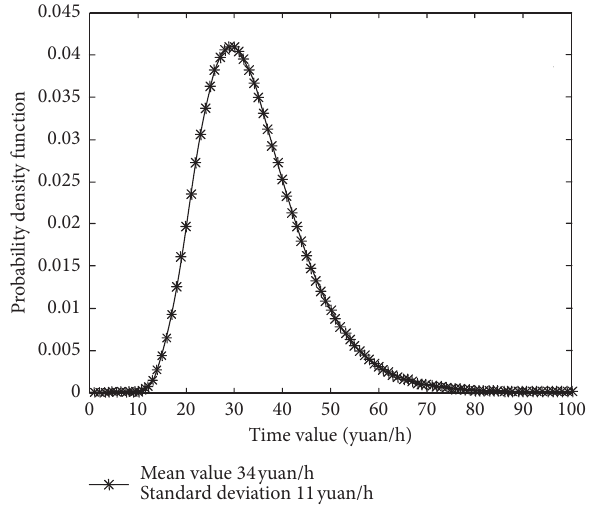
Figure 4: Distribution of passengers’ value of time.